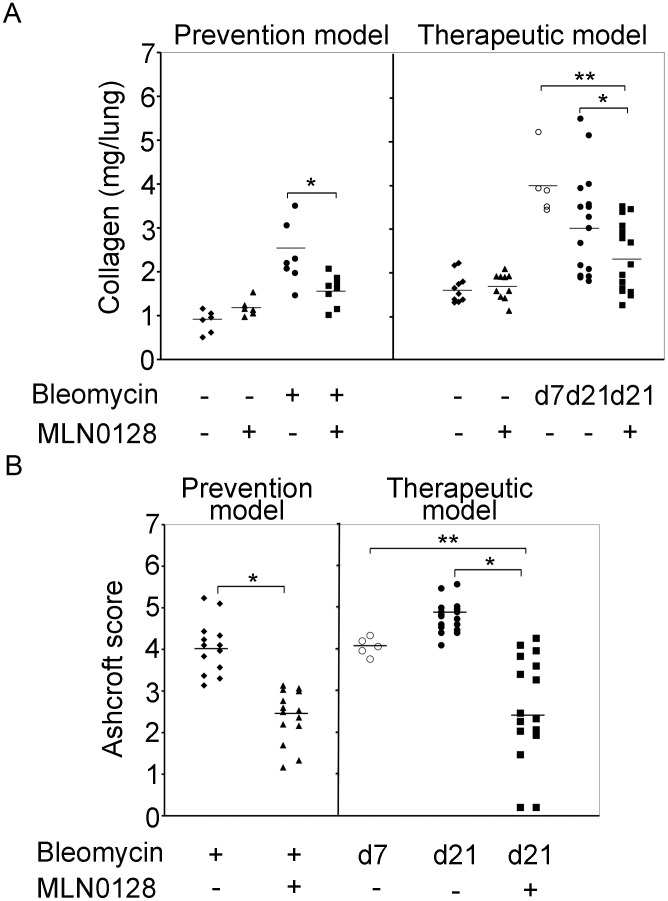
MLN0128 inhibits bleomycin-induced fibrosis.In (A) mice were treated as described in Fig. 5A followed by harvest of the right lung for a Sircoll collagen assay. The horizontal bar represents the mean value of collagen content (mg/lung) for each sample group. *P<0.05. (B) Analysis of Ashcroft score in left lung of mice from (A); *P<0.001. Data shown is combined from four independent prevention model and five independent therapeutic model experiments.